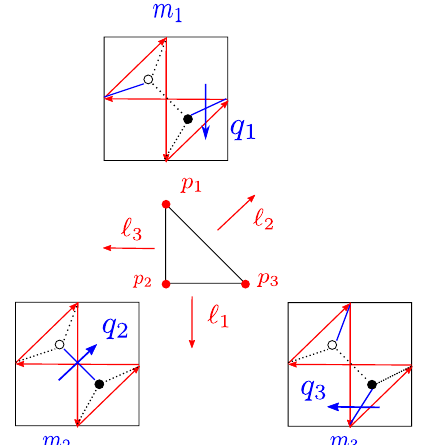
Figure 24. Perfect matchings of C 3 . There are three corner divisors p i ( i = 1 , 2 , 3) , and for each of them there is a unique perfect matching m